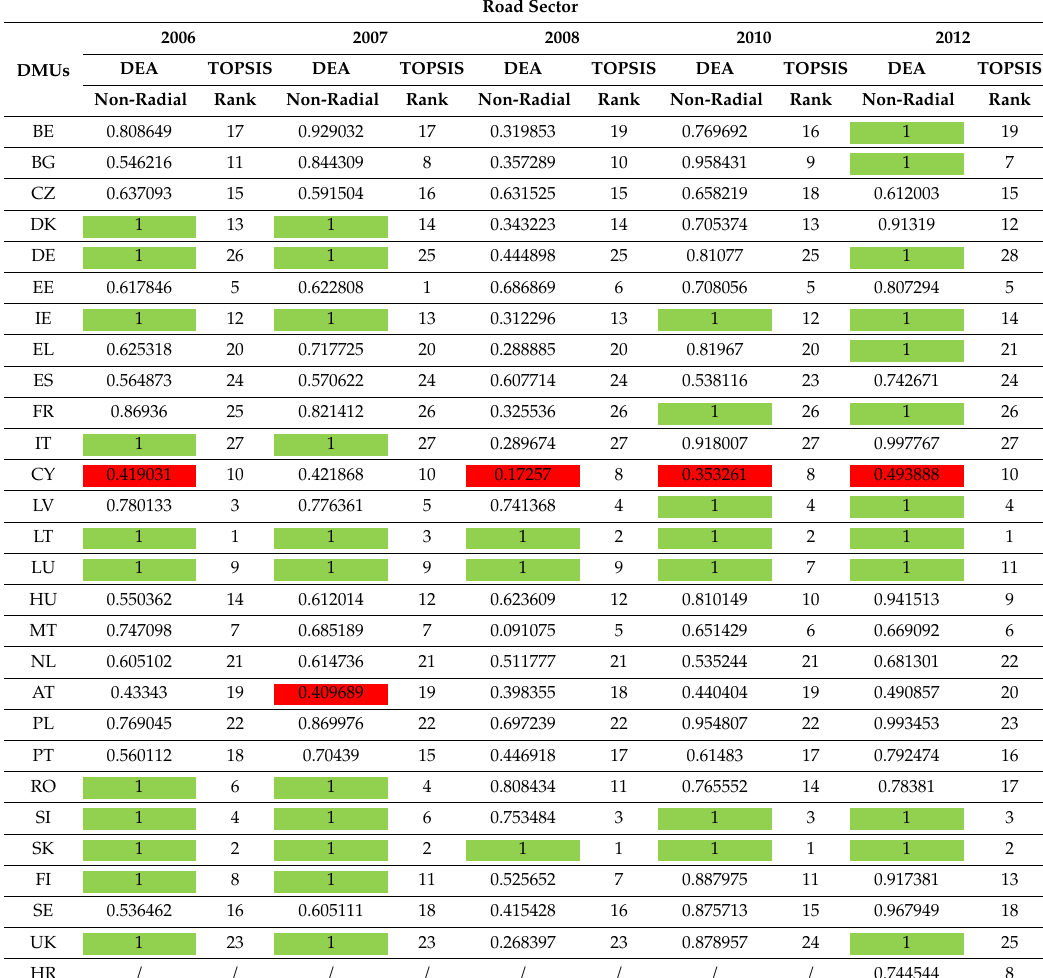
Green color: the best EEEI . Red color: the least EEEI